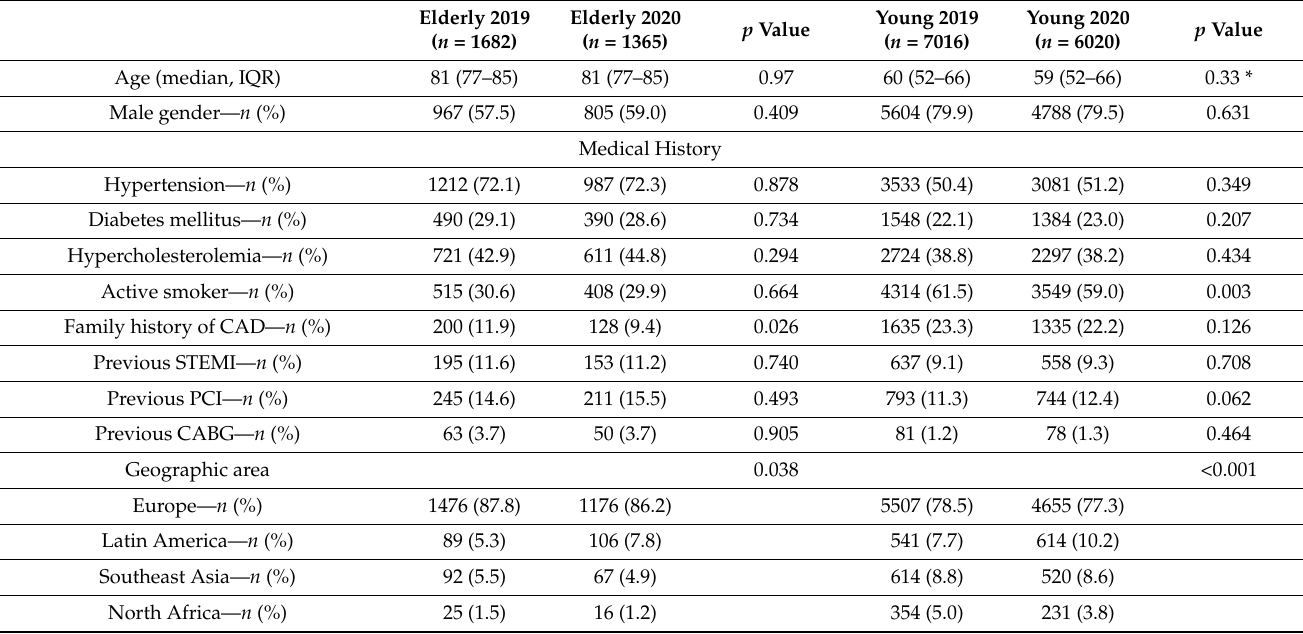
Table 1. Baseline demographic and clinical